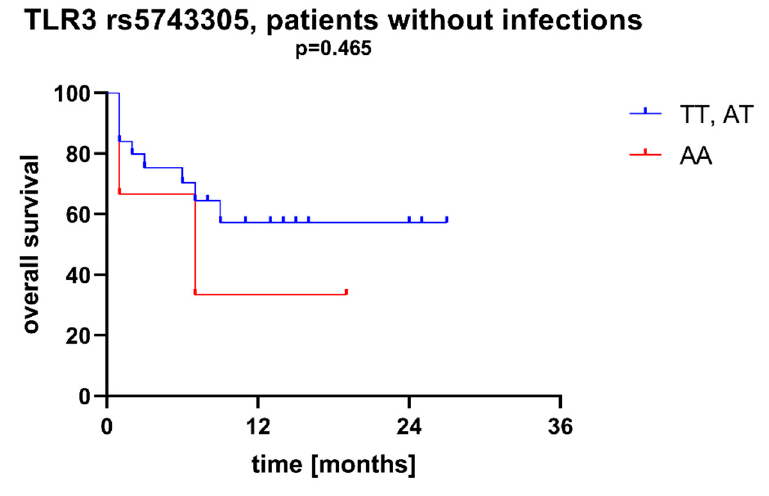
Figure 6. Overall survival of patients with different SNPs in TLR3 rs5743305—patients without infections during AML therapy. Table 1. Summary of correlations between SNPs in genes coding for TLR3, TLR4, and TLR9 and different clinical features in patients with AML. For statistically significant results ( p < 0.05), bold font is used.